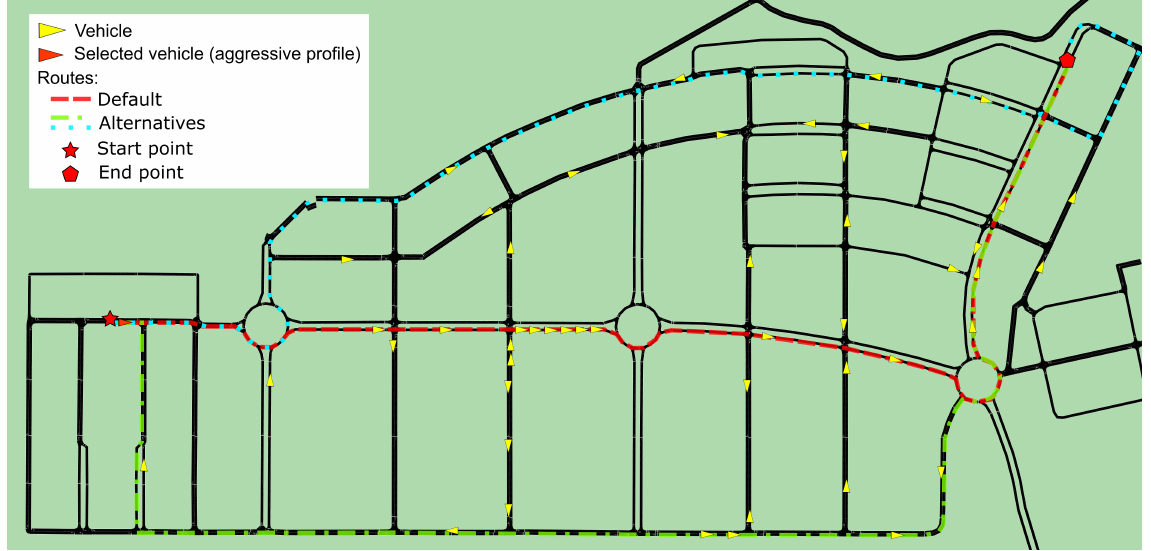
Figure 8. Example of a route optimization case using the fuzzy classification